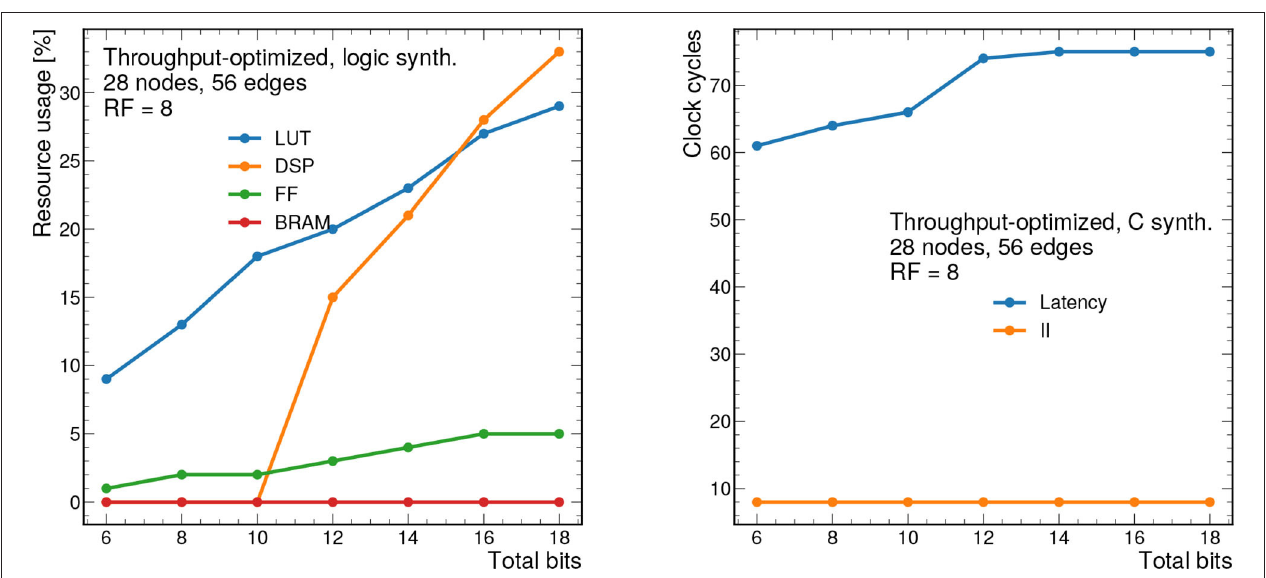
bits are used for each the integer and fractional parts, but the results generalize to other quantization schemes. The